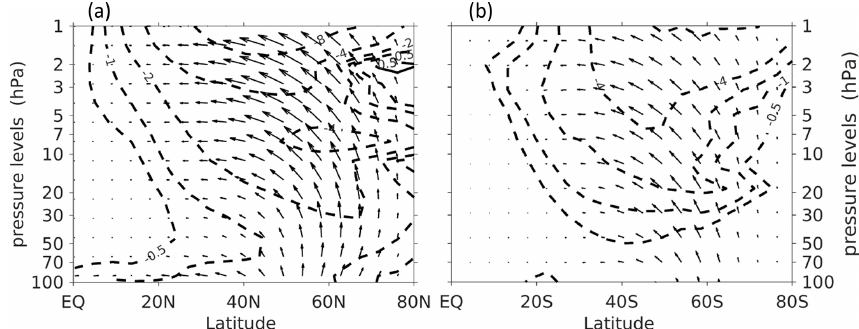
Figure 4. Climatological mean F (arrows) and ∇ · F /(ρ 0 a cos φ) (contours levels: ± 0 . 5 , ± 1 . 0 , ± 2 , ± 4, and ± 8 ms − 1 d − 1 , with dashed contours denoting negative values) for (a) December–February in the NH and (b) June–August in the SH, based on ERA-Interim (Dee et al., 2011) for the period of 1979–2018. Note the Equator is on the left in panels (a) and (b) . For a clearer visualization of the direction of wave 0 . 6 propagation F is scaled as (p s /p) aπ Figure is courtesy of Hua Lu. Figure 4a adapted with permission from Fig. 1b of Lu et al. (2015). ©American Meteorological